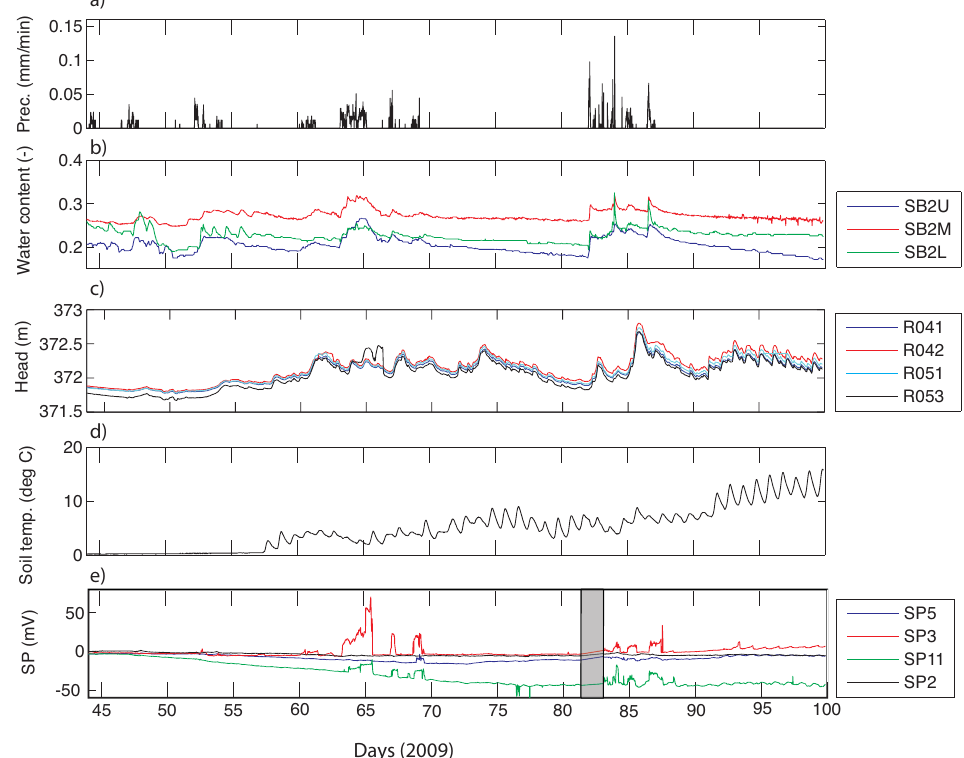
Fig. 4. Time-series of (a) rainfall intensity, (b) water content at 10cm depth (see Fig. 3 for location of sensors), (c) hydraulic head, (d) soil temperature at 10cm depth at location SB2M, and (e) SP signals from four of the SP monitoring electrodes. The gray area in (e) indicates a period when no SP data are